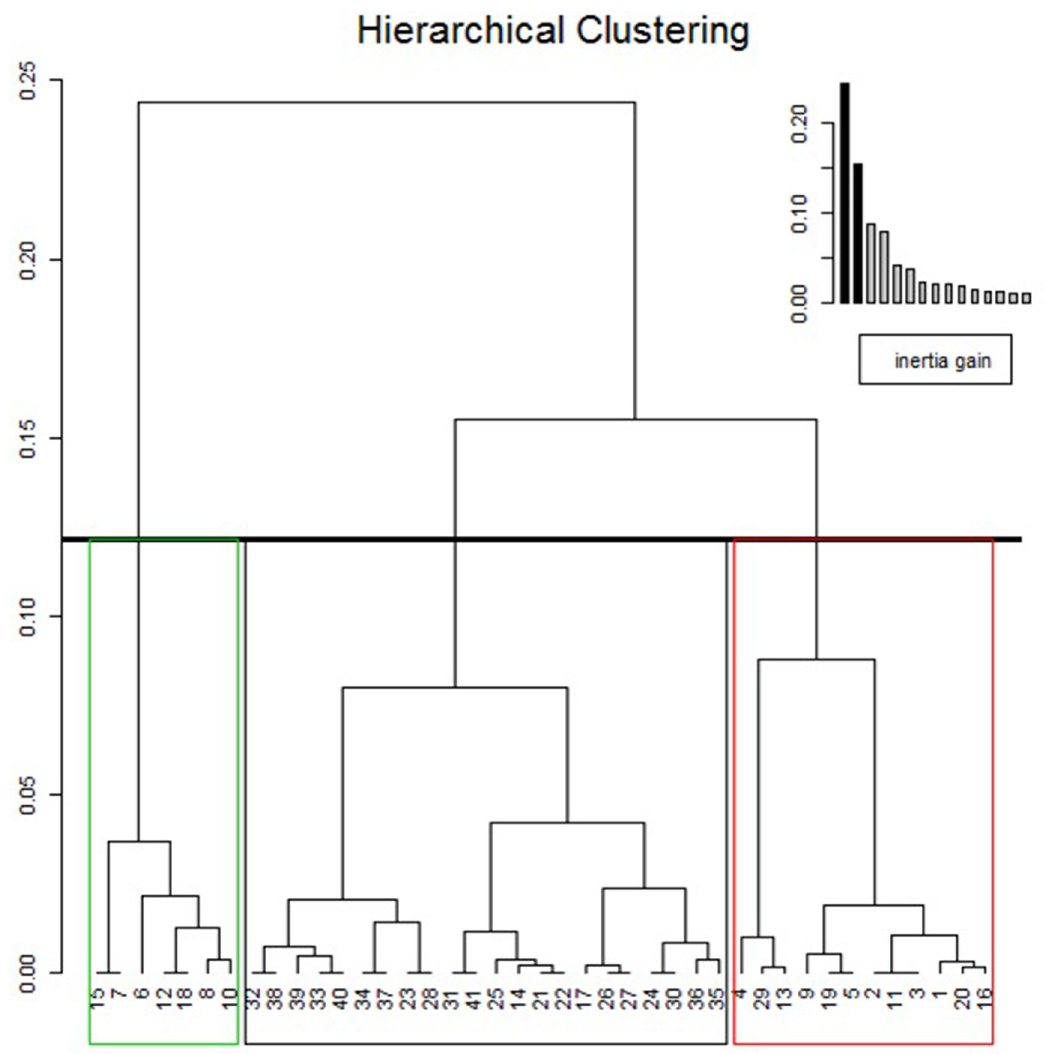
Fig 2. Hierarchical clustering on the first 5 dimensions of the multiple component analysis performed on data of the 41 males with complete data. H3: 35% < Left ventricular ejection function (LVEF) � 50% and/or a need of pacemaker (PM) implantation and/or angina.